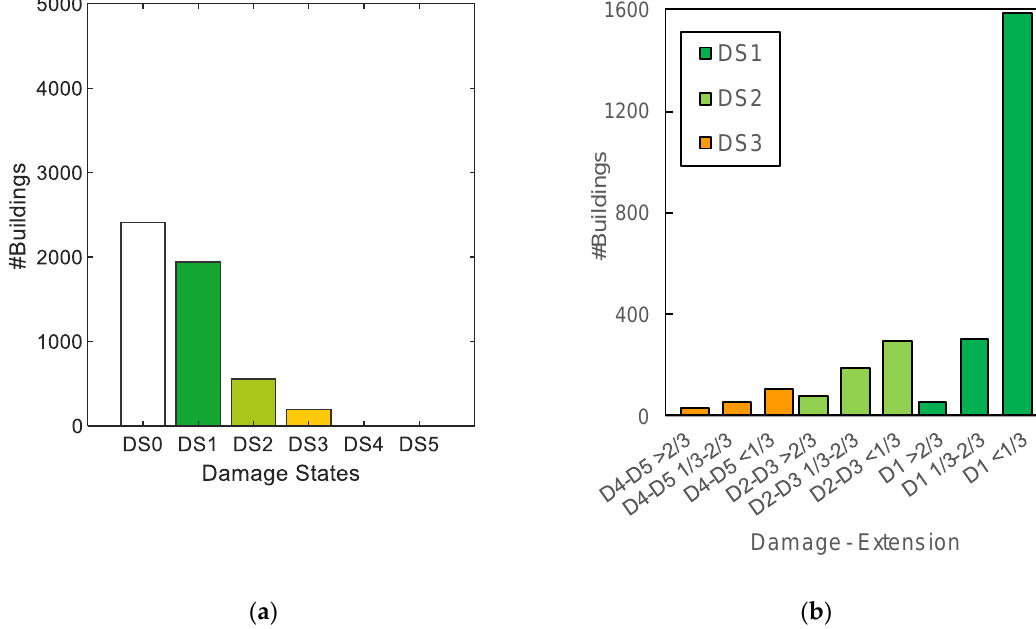
Figure 8. “Observed” maximum damage scenario for “lightly damaged” RC buildings ( a ), and details about the extent of the maximum damage in each DS ( b ).